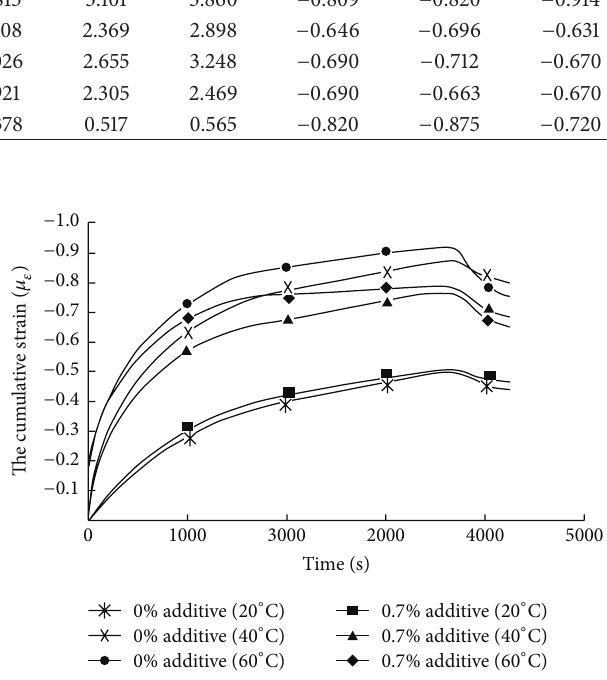
Figure 2: Creep curves of 70#-1 asphalt at different